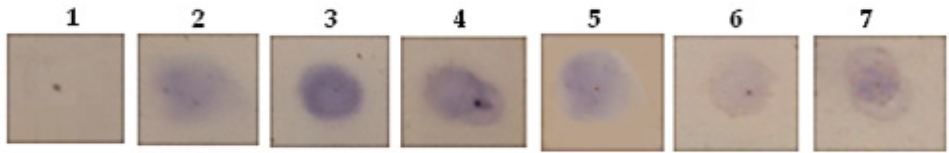
Figure 2. Carbohydrate orcinol/H 2 SO 4 test. Position 1: negative control (H 2 O); position 2: mannose (0.5 mg/mL); position 3: mannose (1 mg/mL); position 4: RvH1; position 5: RvH2; position 6: fraction with Mw 10–100 kDa; position 7: fraction with Mw 50–100 kDa.